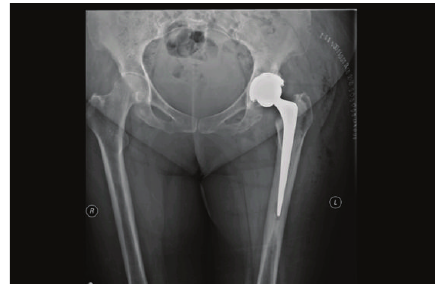
Figure 1: Plain radiograph taken on day 1 after initial left total hip arthroplasty.